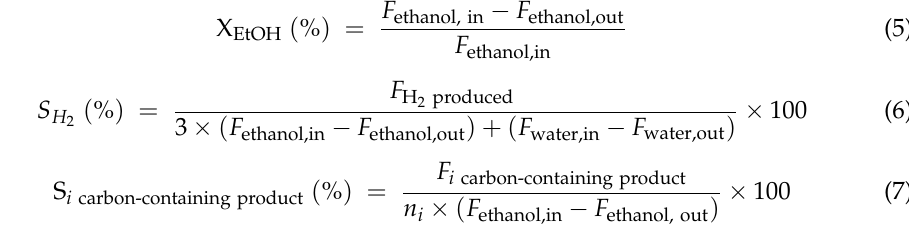
Figure 5. ( a ) H 2 yields and ( b ) cumulative H 2 volumes of the NaOH_T + R and NaHCO 3 _T + R catalysts in the ESR reactions; Volume percentages of product gas composition of the NaOH_T + R catalyst ( c ) and NaHCO 3 _T + R catalyst ( d ) in the ESR reactions. The ethanol conversions (X EtOH ) and selectivity (S) of the productions after ESR reactions catalyzed by the NaOH_T + R and NaHCO 3 _T + R catalysts were calculated using Equations (5)–(7) and were provided in Table 1.